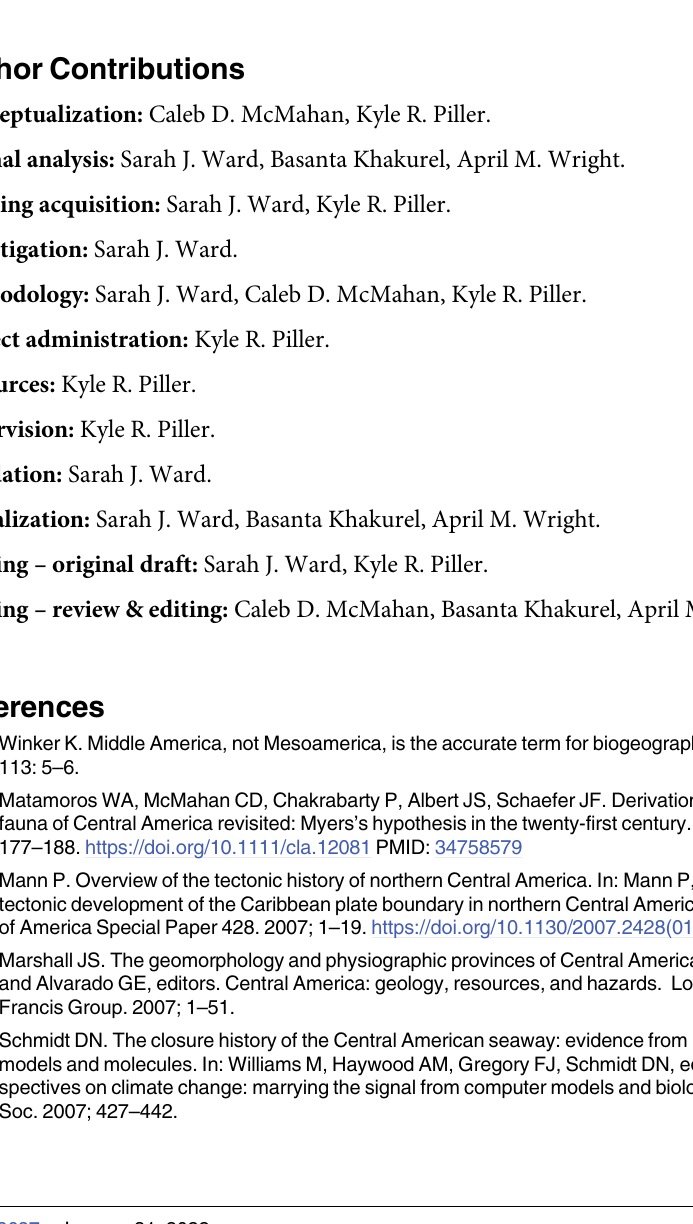
S2 Table. Sampling localities of outgroup individuals. S3 Table. Barcodes and batch information. S4 Table. Parameters used for assembly of concatenated